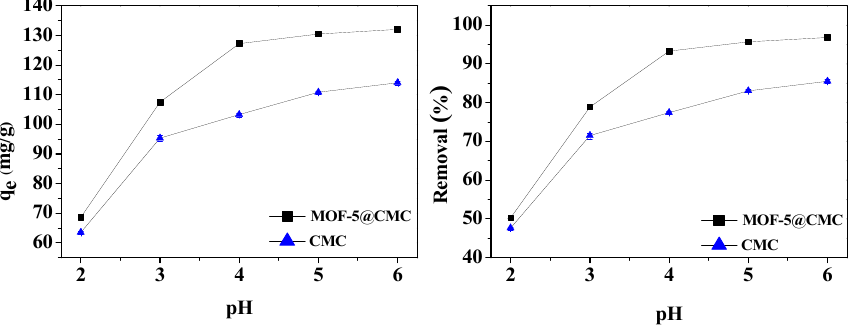
Figure 7. Adsorption capacity and removal rate as functions of pH.